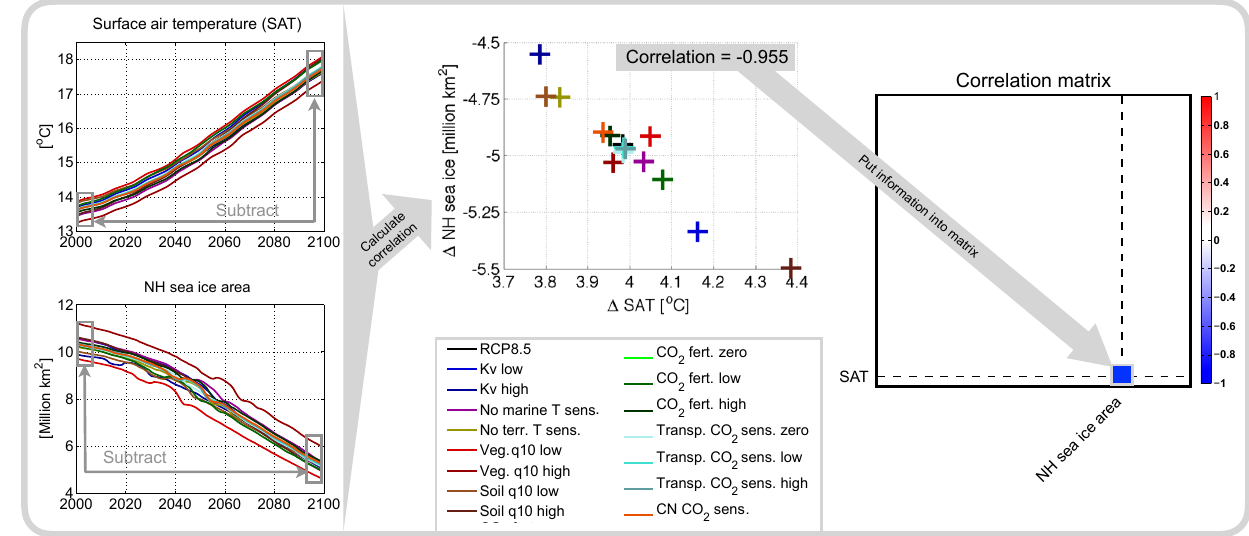
Figure 1. Illustration of the correlation matrix construction for the example case study, and the model output variables surface air tempera- ture (SAT) and Northern Hemisphere (NH) sea ice area. In the first step, temporal differences of the simulations are calculated between 2005– 2015 and 2090–2100. Second, changes in the variables induced by the parameter perturbations are correlated. Last, this correlation informa- tion is used as one of many entries in the correlation matrix. Table 1. List of perturbed model input